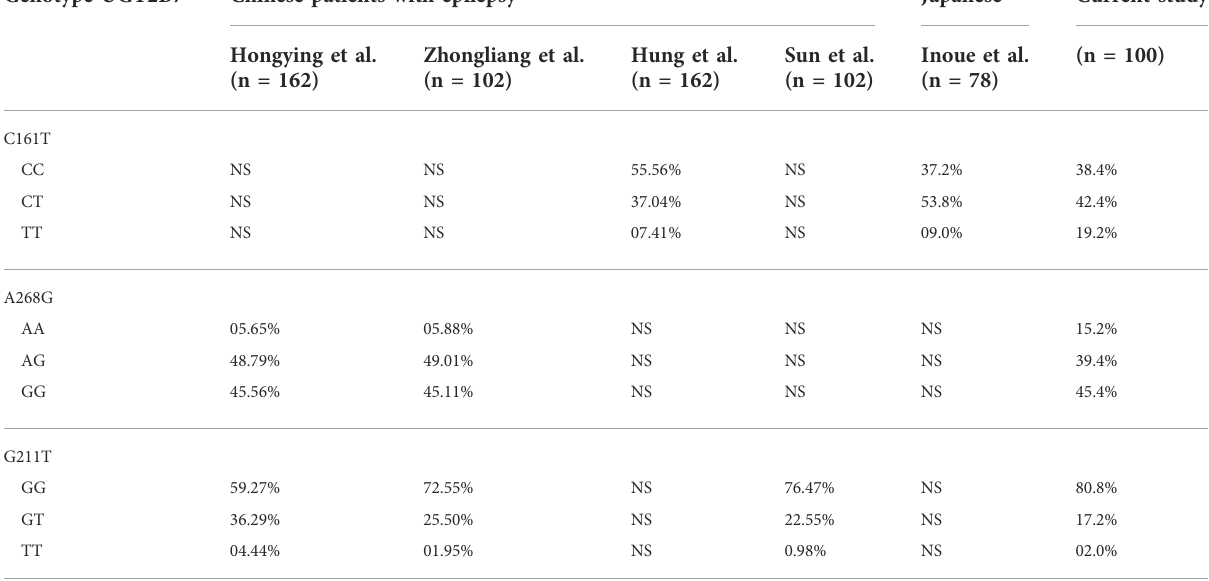
TABLE 8 Details of prevalence of UGT2B7 gene polymorphisms in various